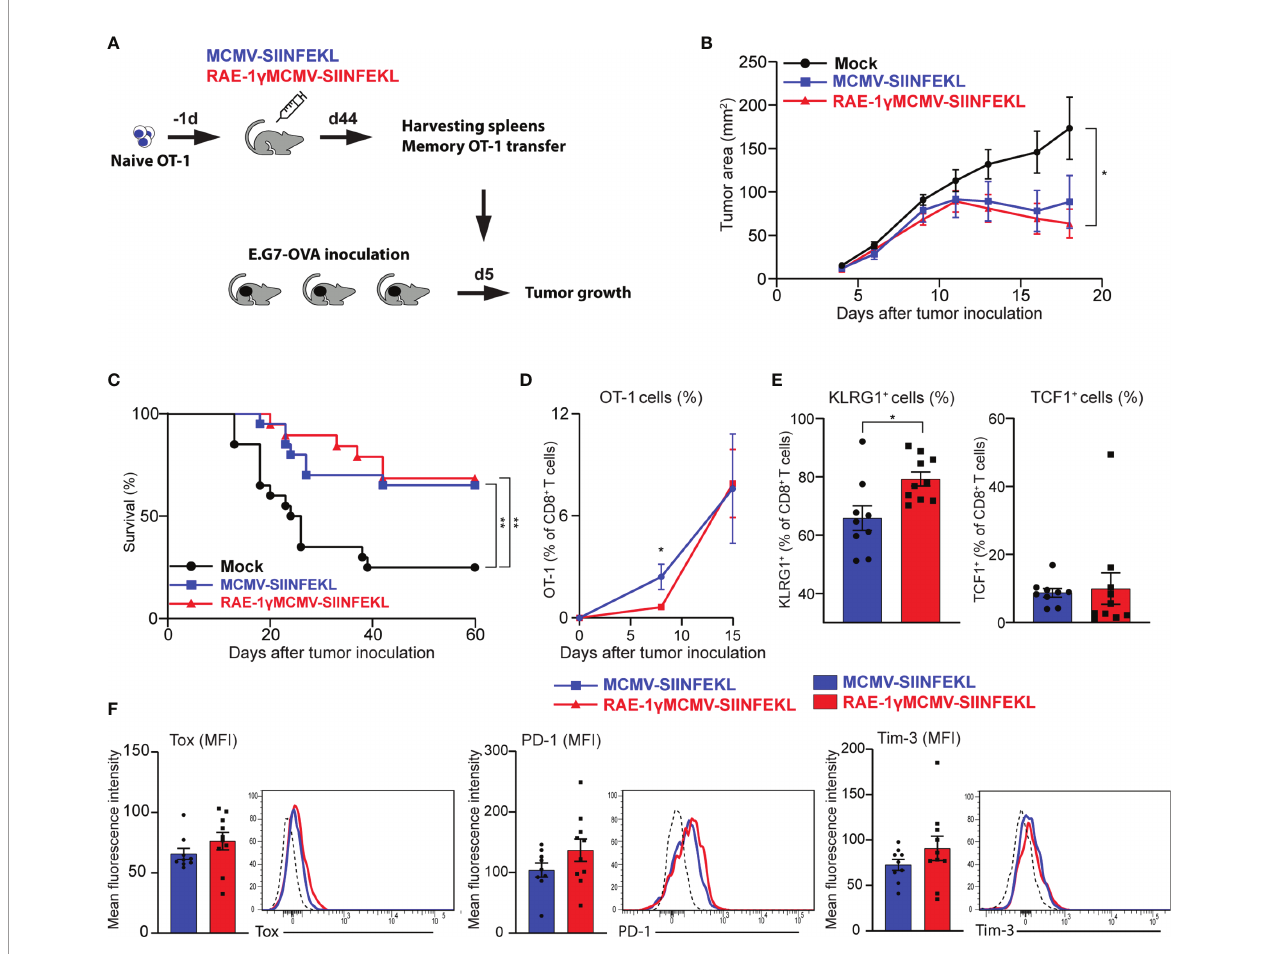
FIGURE 5 | Adoptively transferred CD8 T cells primed with RAE-1 g MCMV vector show protective potential similar to cells primed with the MCMV lacking RAE-1 g . (A) Naïve OT-1 cells were transferred into C57BL/6 mice (n=8-10) one day prior to immunization with indicated viruses. On day 44 after immunization, 3x10 4 memory OT-1 cells were sorted and transferred to mice (n=11) that were inoculated with E.G7-OVA tumors 5 days prior to OT-1 transfer. Tumor growth (B) and overall survival (C) were followed over time. (D) The frequency of OT-1 cells was determined in blood at indicated time points. (E, F) The phenotype of OT-1 cells was analyzed on day 15 following adoptive transfer in blood. Data are from a single experiment representative of two independent experiments (B, D – F) . Survival data are pooled from two independent experiments (C) . Data are represented as mean ± SEM and statistical signi fi cance *p < 0.05; **p < 0.01. Statistical signi fi cance was determined using one-way ANOVA followed by LSD post test (B) , log-rank Mantel-Cox test (C) , or unpaired Student t-test (D – F)